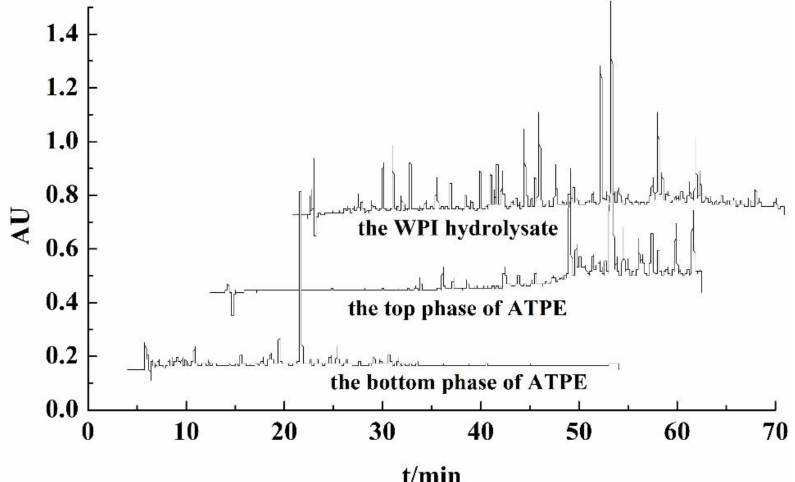
Figure 4. RP-HPLC chromatograms of the WPI hydrolysate, the top and bottom of ATPE under optimal conditions.